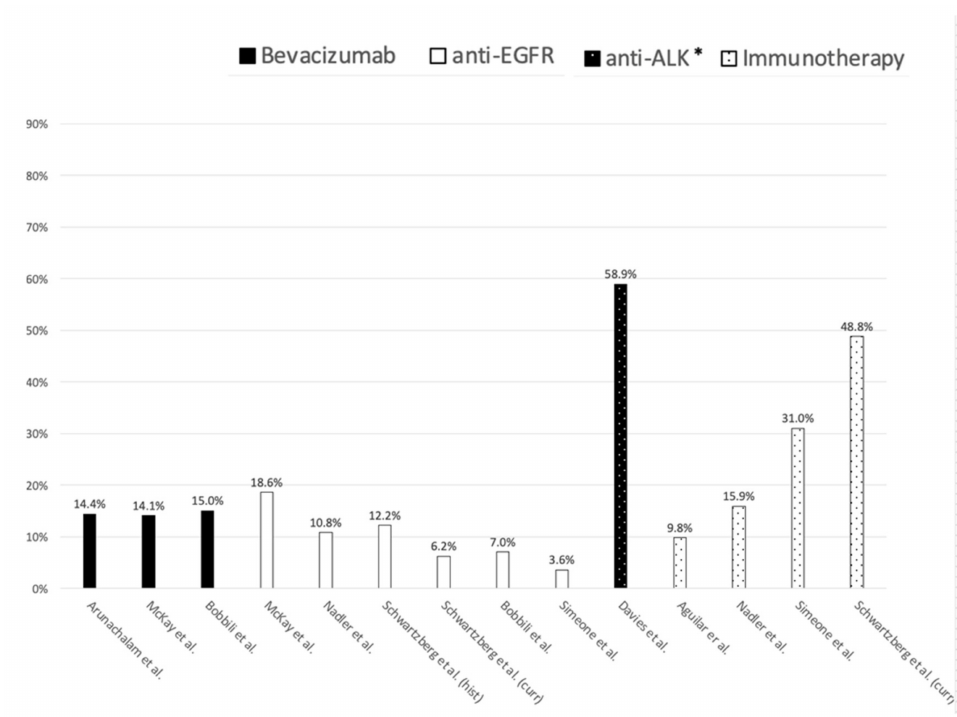
Figure 3. Reported incidence of use of innovative drugs as second-line pharmacotherapy for NSCLC. * Utilization was assessed in patient with anaplastic lymphoma (ALK)-mutated